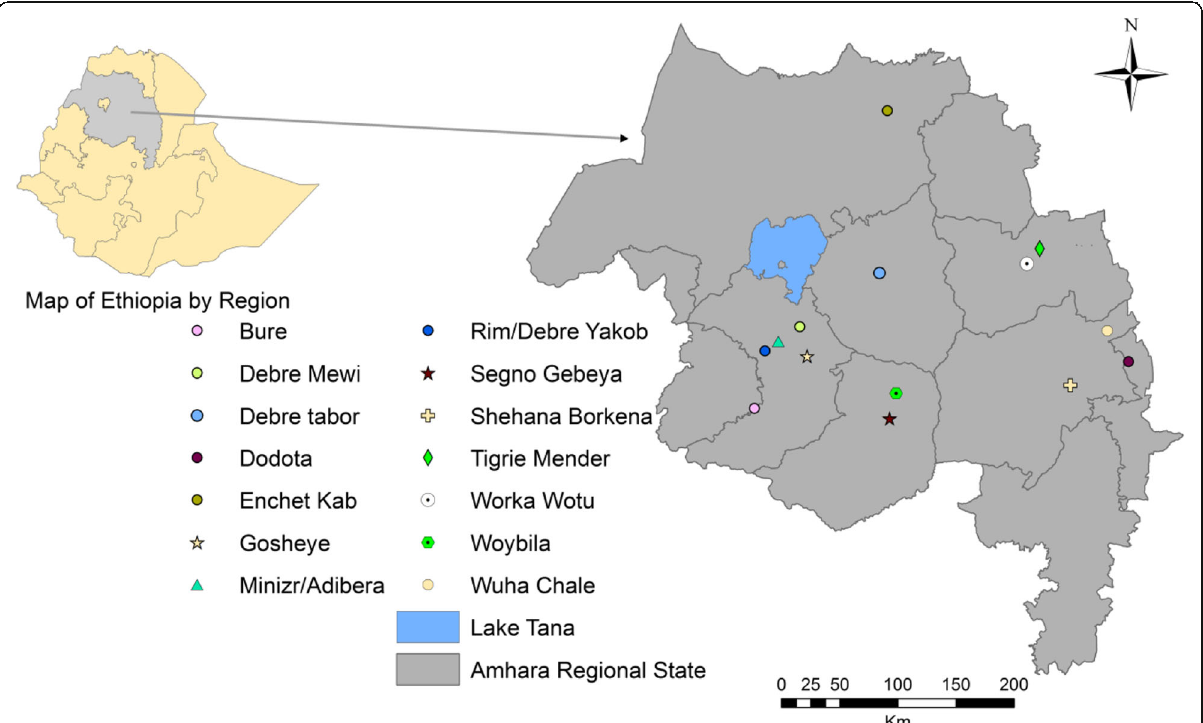
Fig. 1 location map of the study